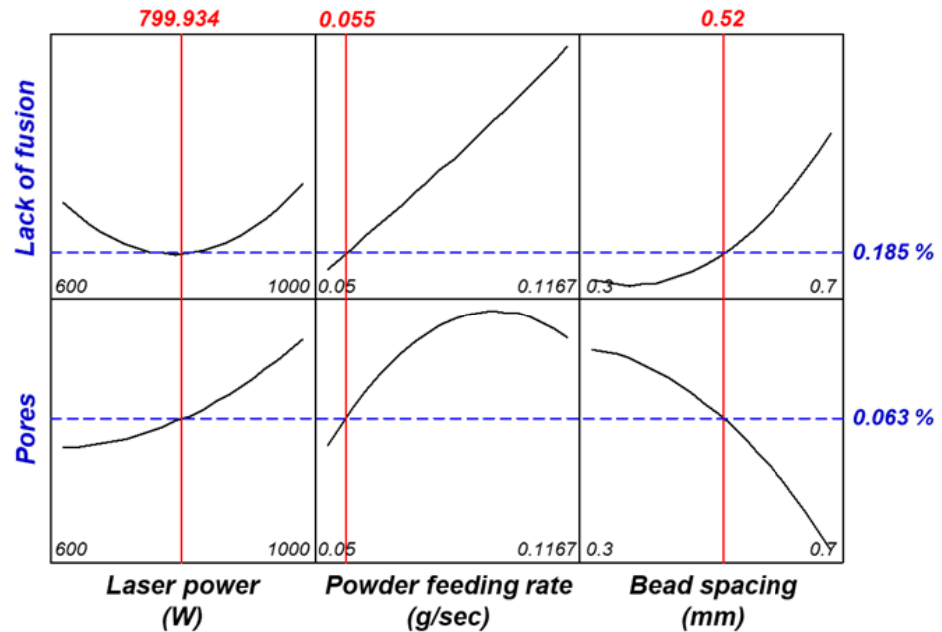
Figure 6. Optimized process parameters of the powder-fed DED for the minimization of the lack of fusion and pores projected onto the response surfaces for the regression models.